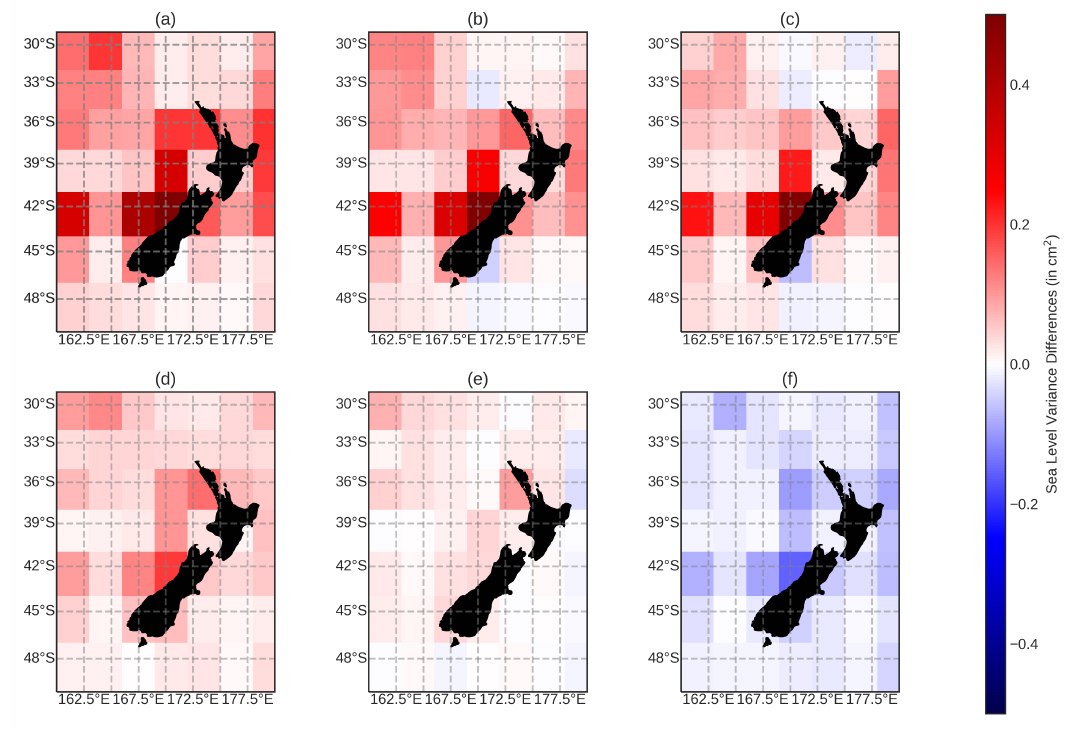
Figure 6. The same as in Figure 5, but for the New Zealand region.